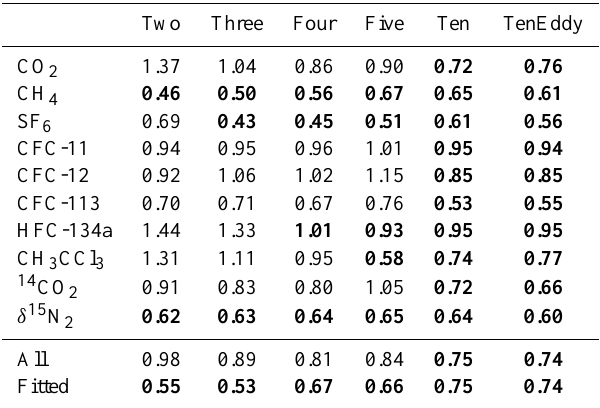
Table 4. Weighted RMS mismatch of calculated concentrations for each tracer from the NEEM observations ( 8 N ) for the best solution from each of the five Subsets in Table 2 plus Subset Ten with expo- nential eddy diffusion (denoted TenEddy), Subset Ten with relative diffusion coefficients estimated (TenDC) and TenEddy with relative diffusion coefficients estimated (TenDCEddy).